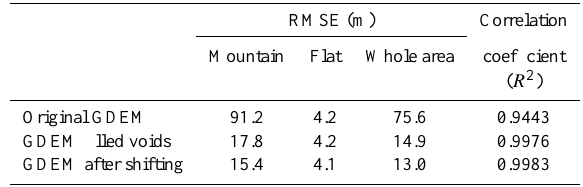
Table 2. Results of GDEM after filling artifacts and shifting. RMSE (m)